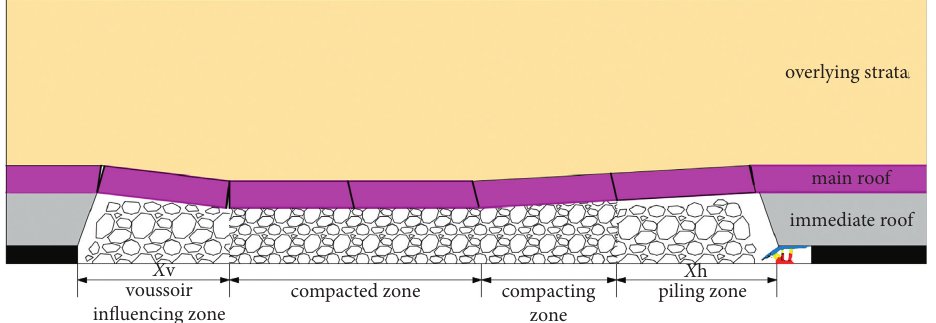
Figure 13: Location of the four zones within the gob area.